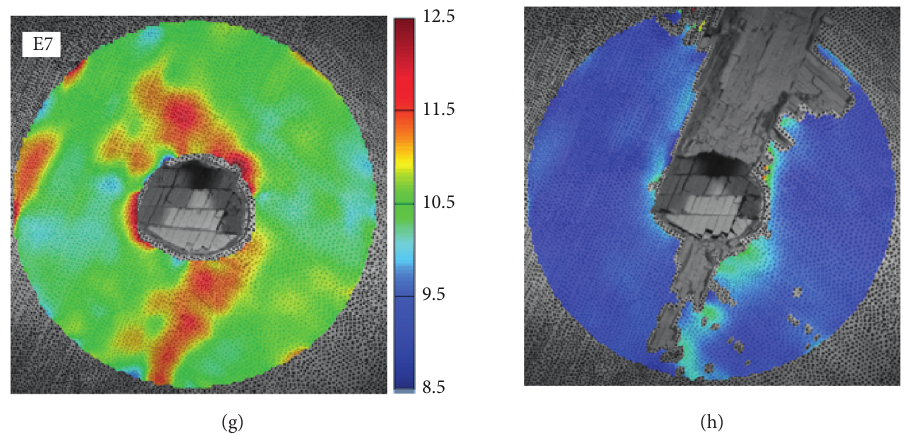
Figure 17: Evolution of displacement field around the tunnel by the DIC method (unit: